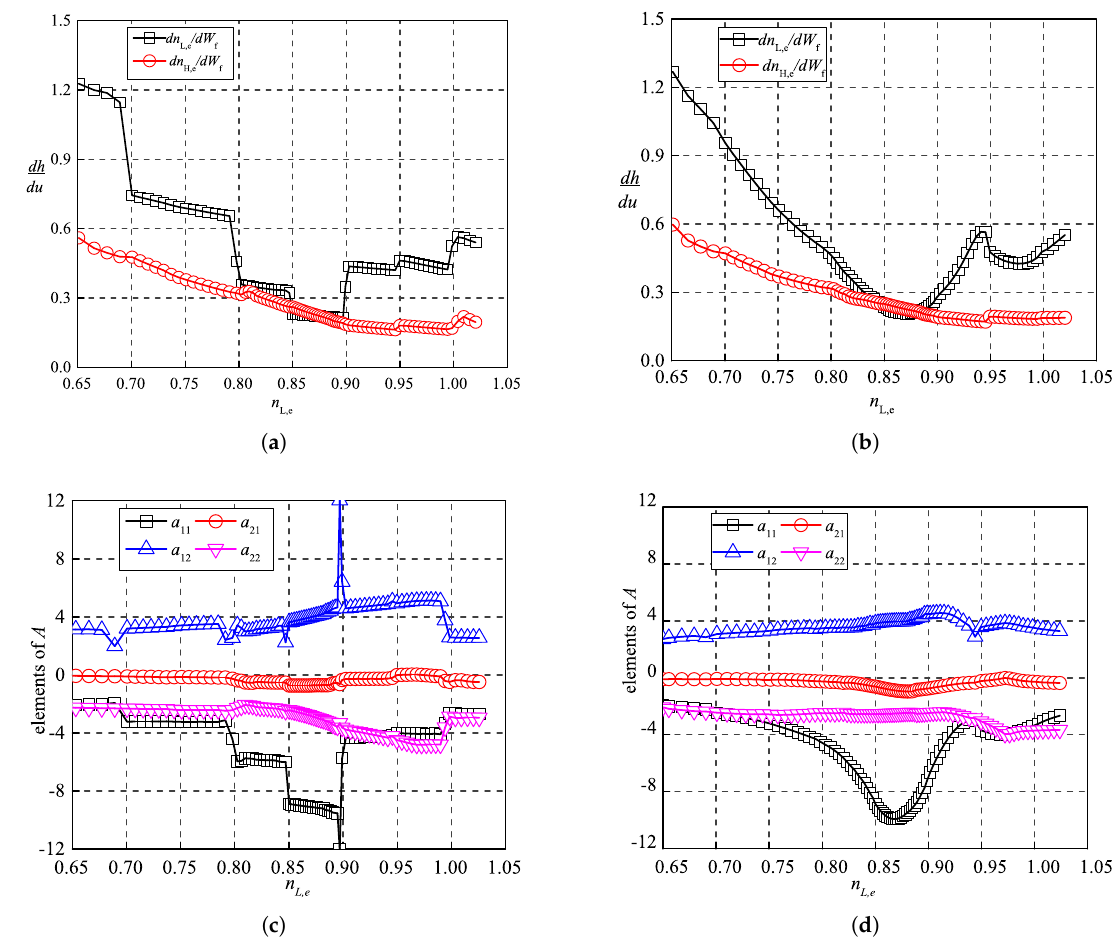
Figure 6. The continuity of dh / du and the elements of A : ( a ) Linear interpolation, ( b ) spline interpolation, ( c ) linear interpolation, and ( d ) spline interpolation.